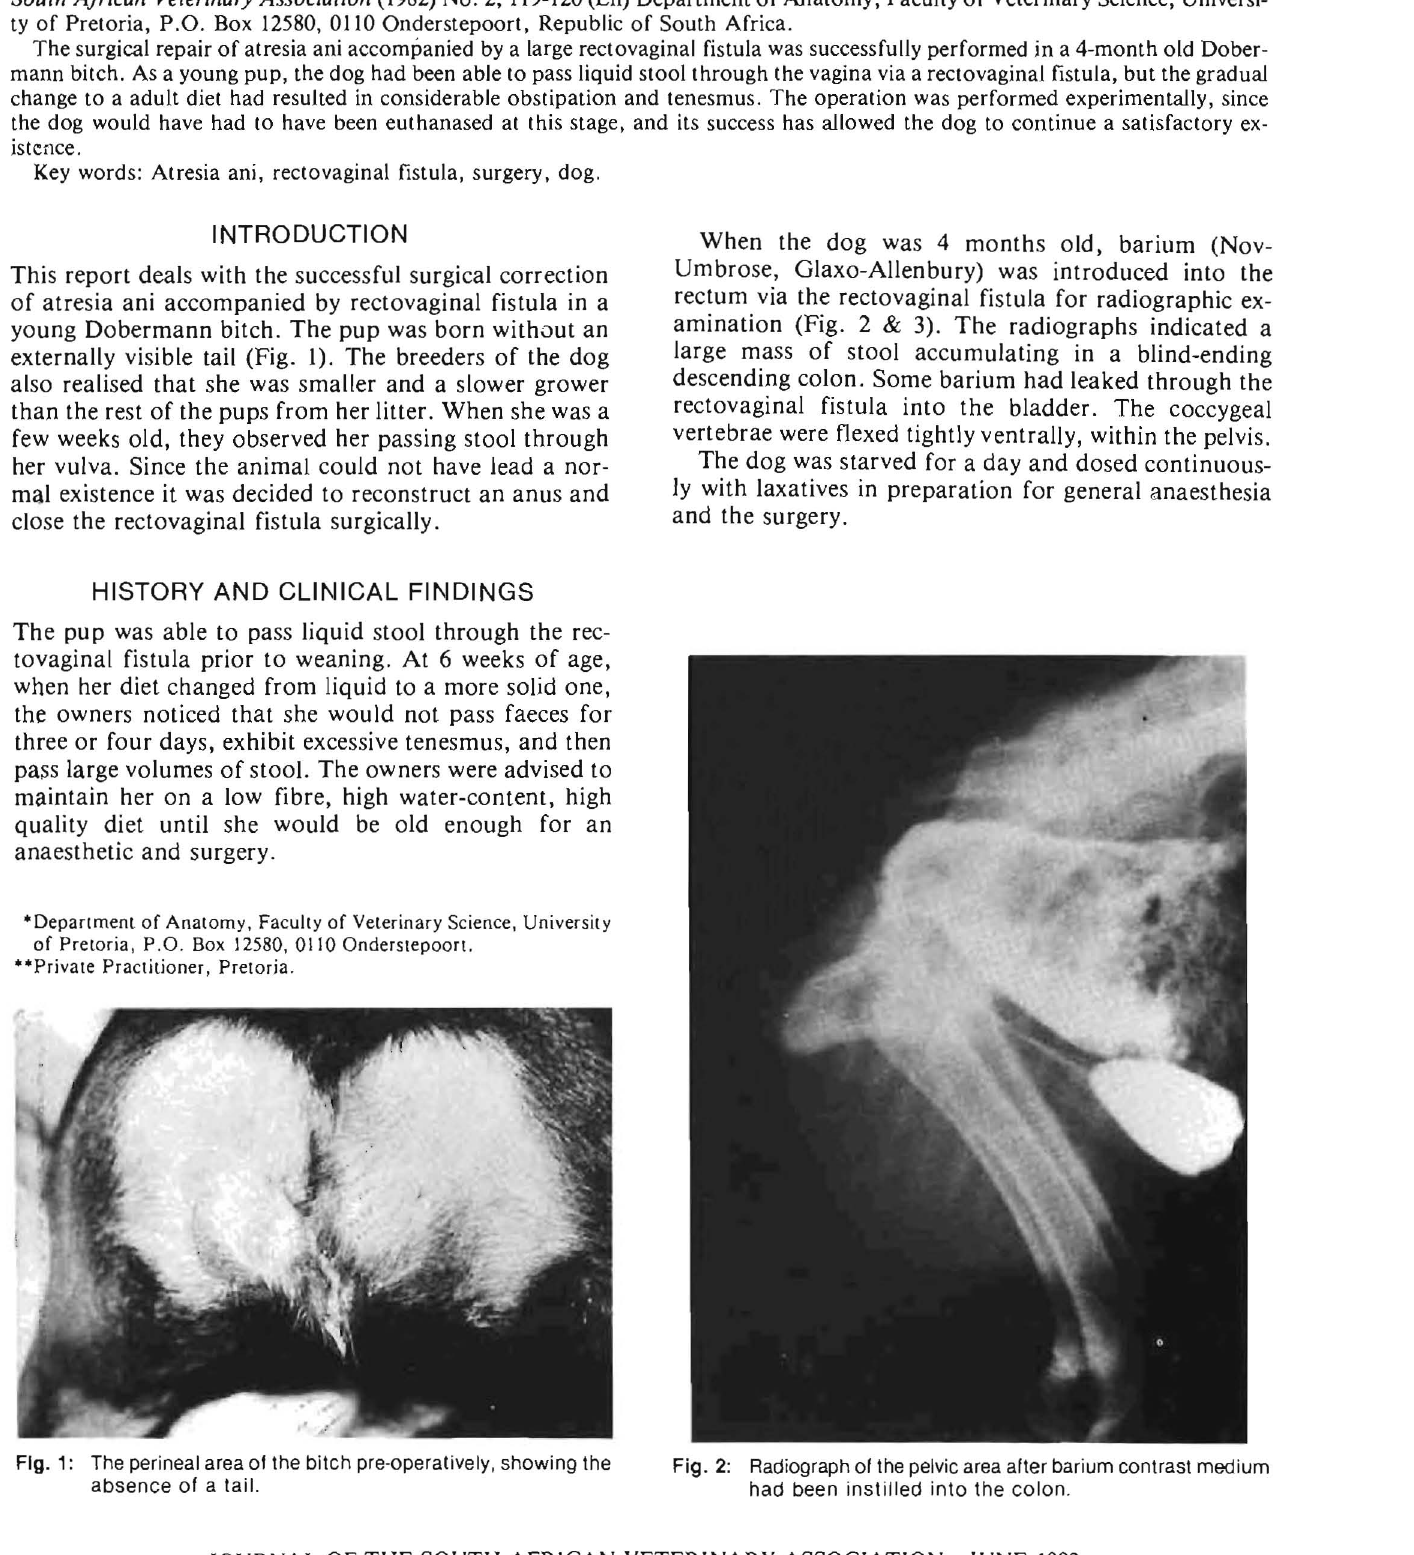
Fig. 1: The perineal area of the bitch pre·operatively, showing the absence of a tail.